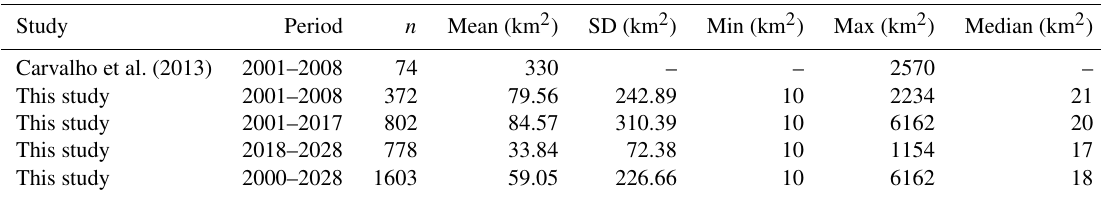
Figure 7. Empirical bamboo-age reflectance curves at ages 0–28 years from MODIS bands 1 to 8 (a–h) . Black lines represent the median, while the shaded gray areas represent the 1st and 99th percentile. Table 1. Bamboo patch sizes obtained from die-off prediction using MODIS NIR-1 filtered by a minimum patch area of 10km 2 , and comparison of results with those from Carvalho et al.